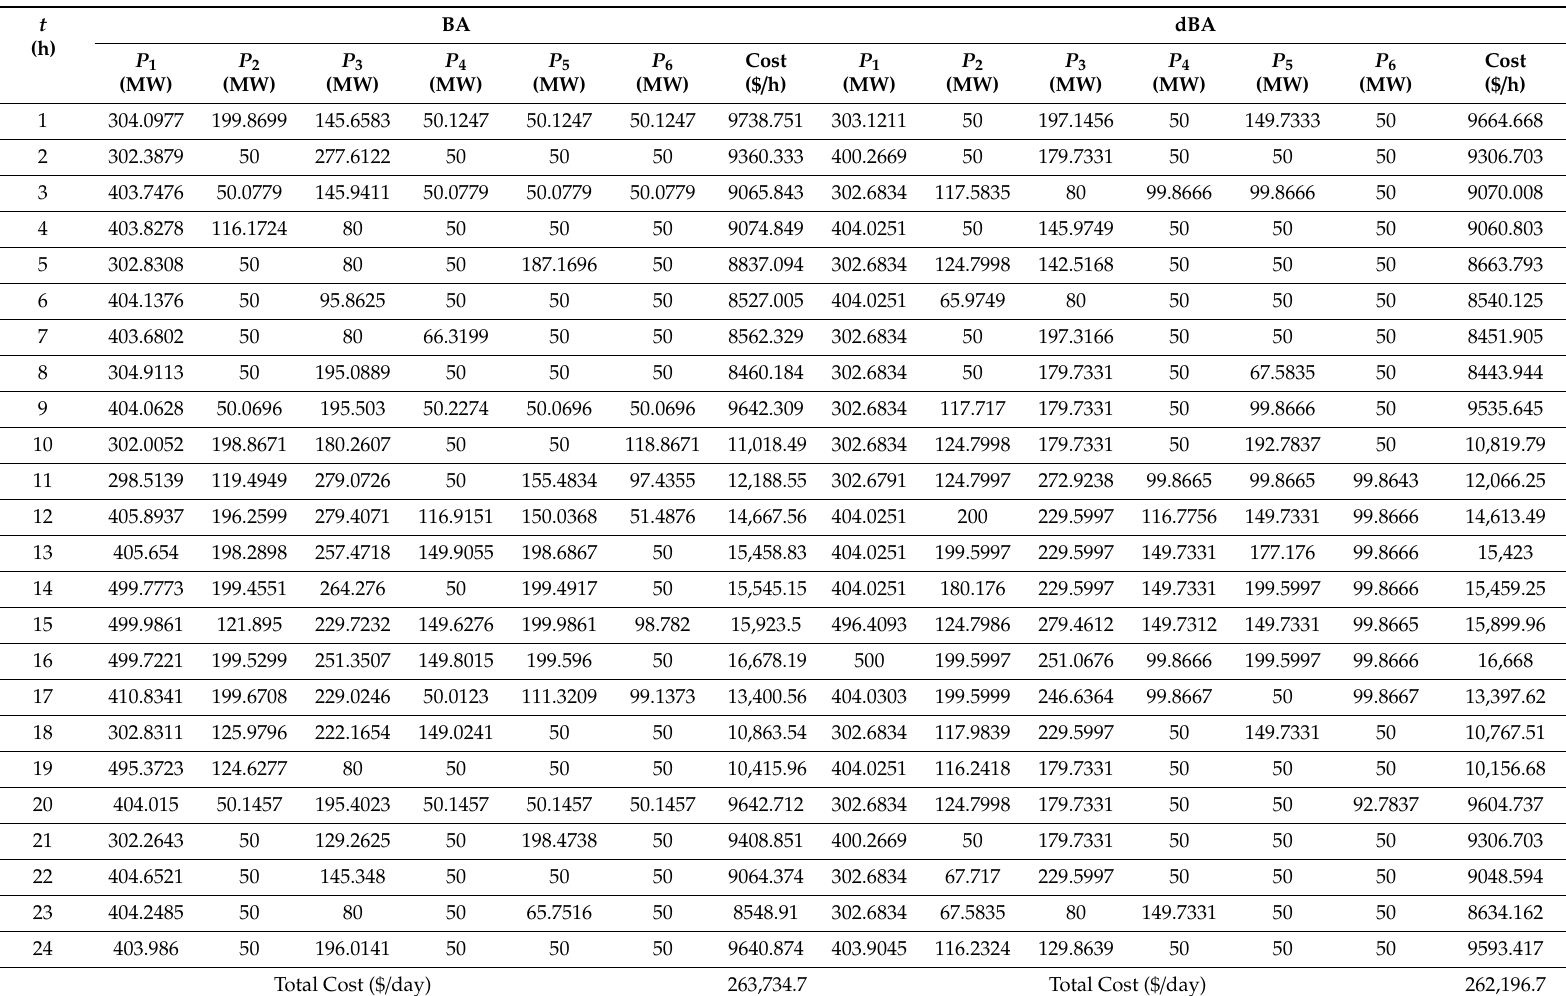
Table 17. The BA and dBA on a six-thermal unit system without